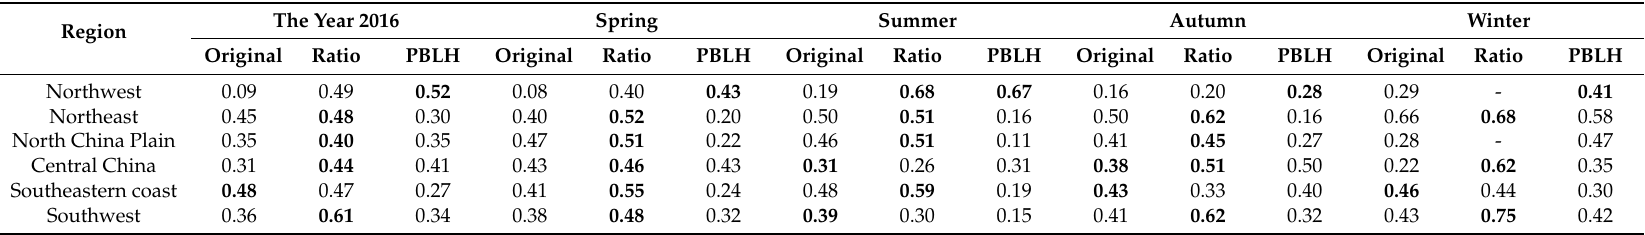
Table 3. The validation experiment results in 2016, including the seasonal Pearson correlation coefficient (R) of PM 2.5 and Original satellite-derived AOD, Revised AOD by CALIOP ratio, and Revised AOD by PBLH. The optimal values of Pearson correlation coefficient were bolded. Spring includes March, April and May; summer includes June, July and August; autumn includes September, October and November; and winter includes December, January and